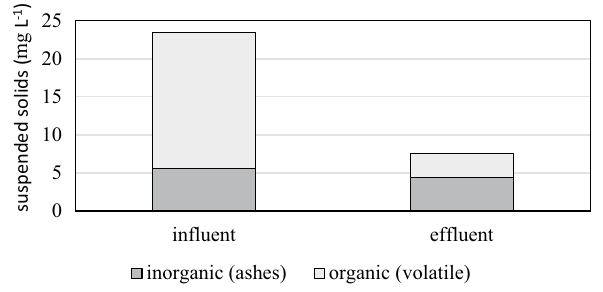
Fig. 8 Concentrations of suspended organic and inorganic solids before and after thermal disinfection of raw wastewater